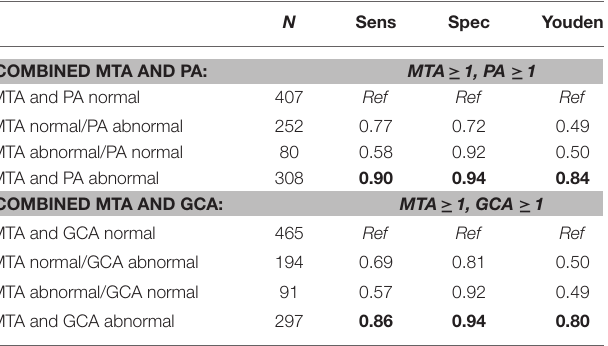
TABLE 5 | Sensitivity and specificity for the combination of MTA and PA and for the combination of MTA and GCA for differentiating AD from controls in age group < 65